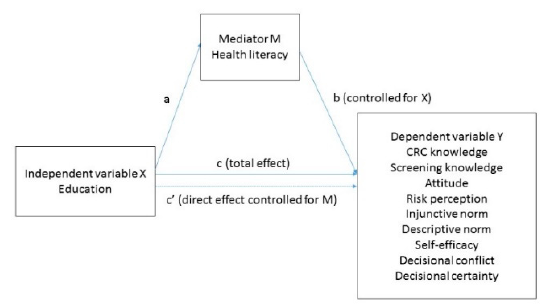
Figure 1. Hypothesized conceptual model: The effects of education on informed decision making (IDM) are (partly) mediated by domains of health literacy (HL).